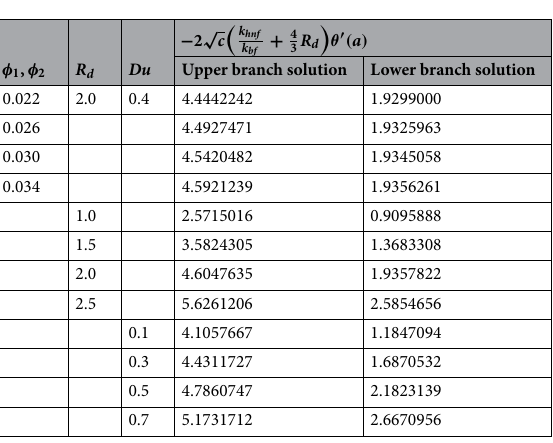
Table 4. The computational output values of the local heat flux for sundry values of the mentioned parameters.